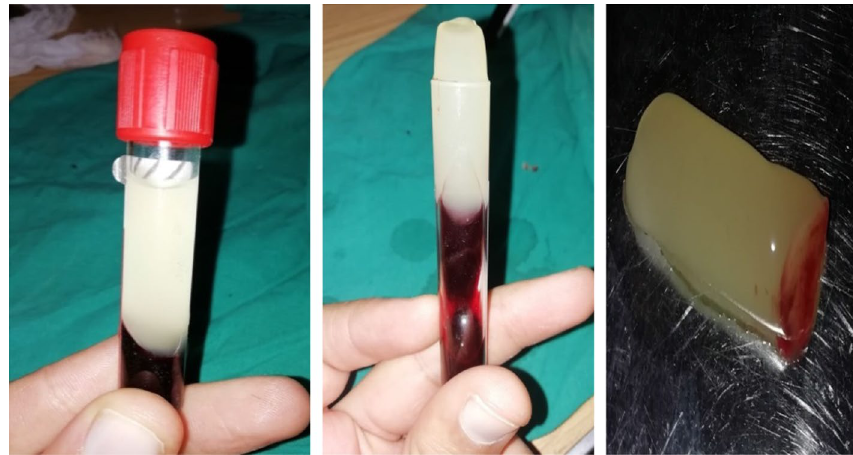
Figure 2. PRF formation after centrifugation of blood at 4000 rpm for 10 min. It looks like a jelly